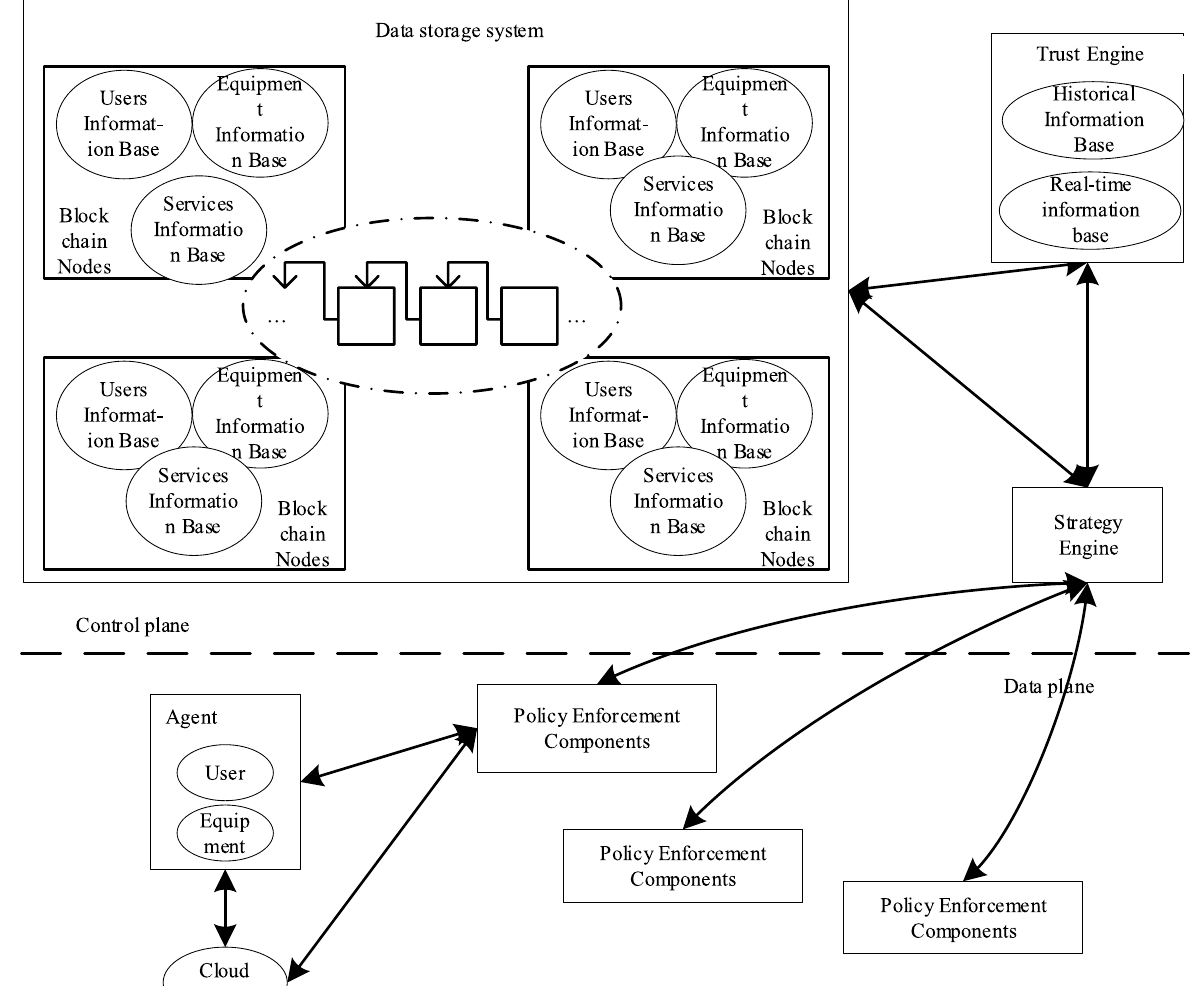
Fig. 4 Blockchain-based zero trust system architecture for